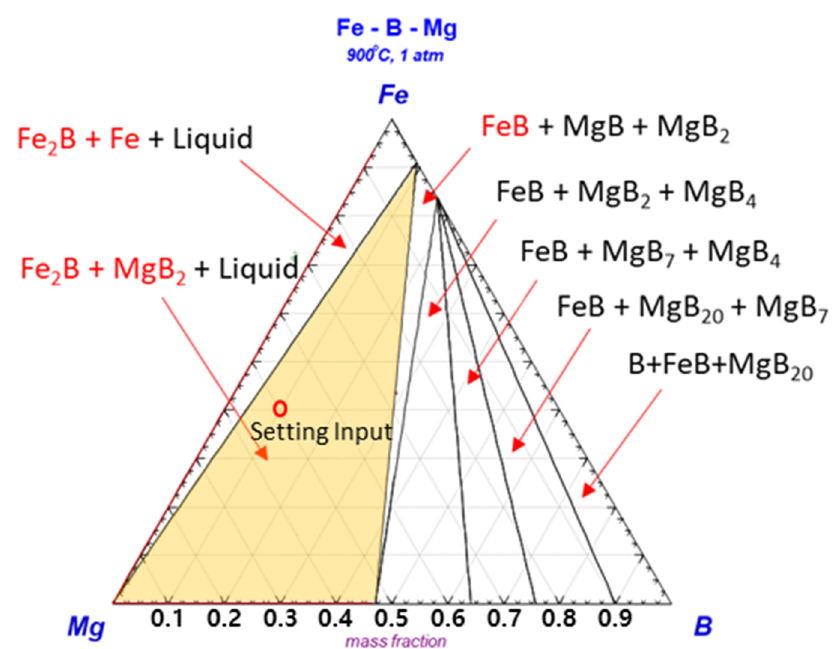
Figure 2. Ternary phase diagram of Mg–Fe–B at 900 °C under 1 atm by